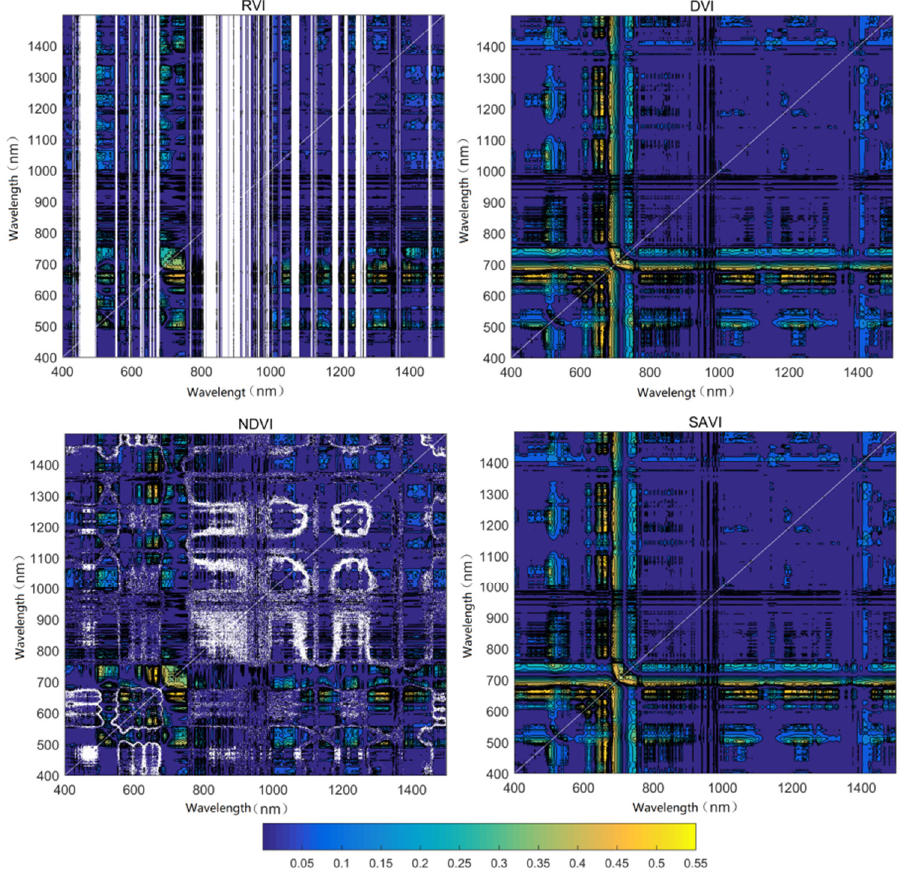
Figure 6. Coefficients of determination ( R 2 ) contour maps of ratio vegetation index ( RVI ), differential vegetation index ( DVI ), normalized vegetation index ( NDVI ) and soil-regulated vegetation index ( SAVI ).